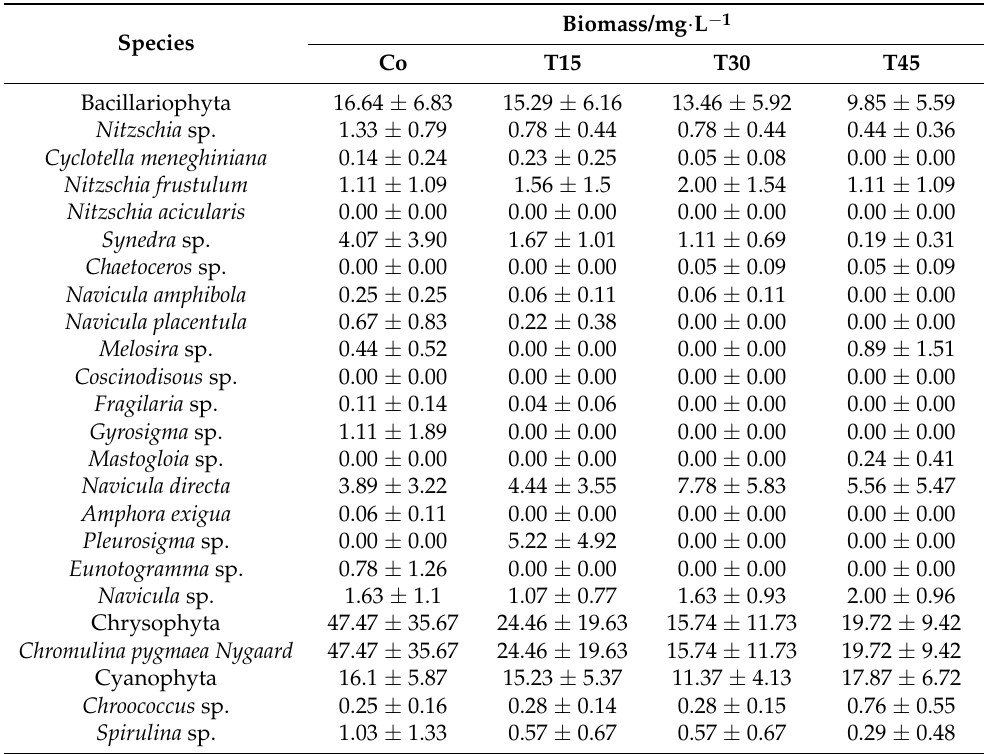
Table A4. Species and biomass of the phytoplankton in each enclosure and grouped by crab diet ( n =